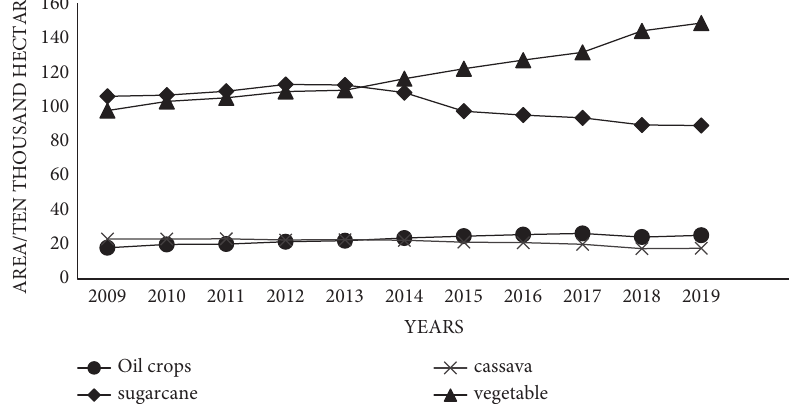
Figure 3: Change of main nongrain crop area in Guangxi from 2009 to 2019.